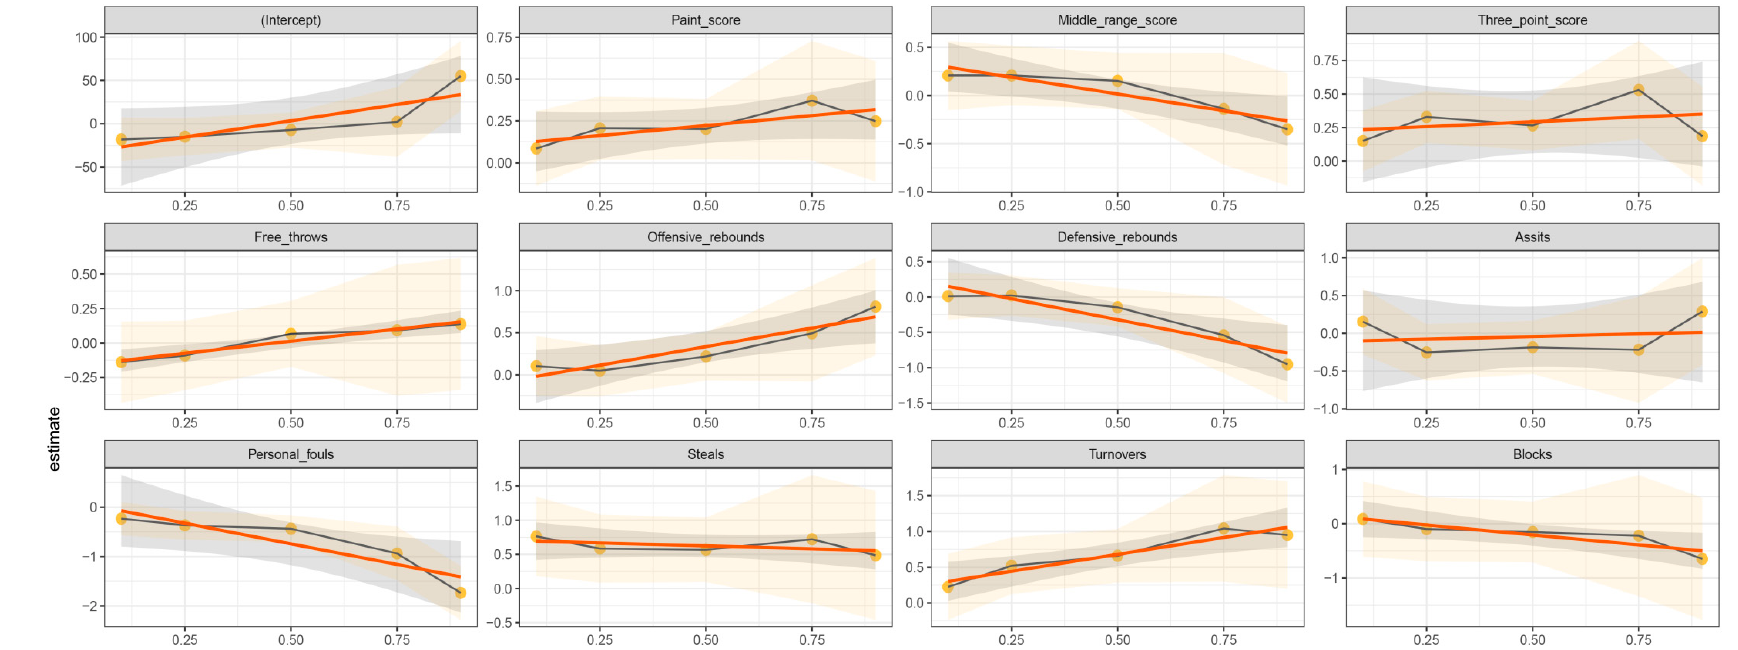
Figure 1. Regression coefficients of MLR and QR for the effect of key performance indicators on match outcome. The horizontal axis lists the different quantiles, while the vertical axis values represent the regression coefficient. The black solid line with yellow dots is the estimate of the regression coefficient for each quantile (0.10, 0.25, 0.50, 0.75 and 0.90), while the light orange shaded area represents the 95% confidence intervals of the coefficients. The red continuous line corresponds with the multiple linear regression coefficients, with the deep gray shaded area representing the 95% confidence intervals of the multiple linear regression estimate.